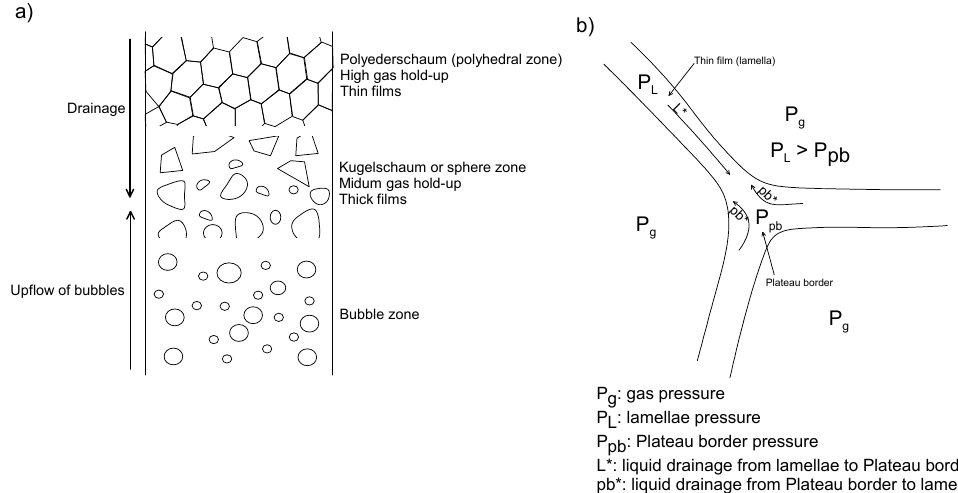
Figure 1. ( a ) Foam structure (adapted from Pugh 1996 [14]) and ( b ) phenomena occurring in the thin film and Plateau border.